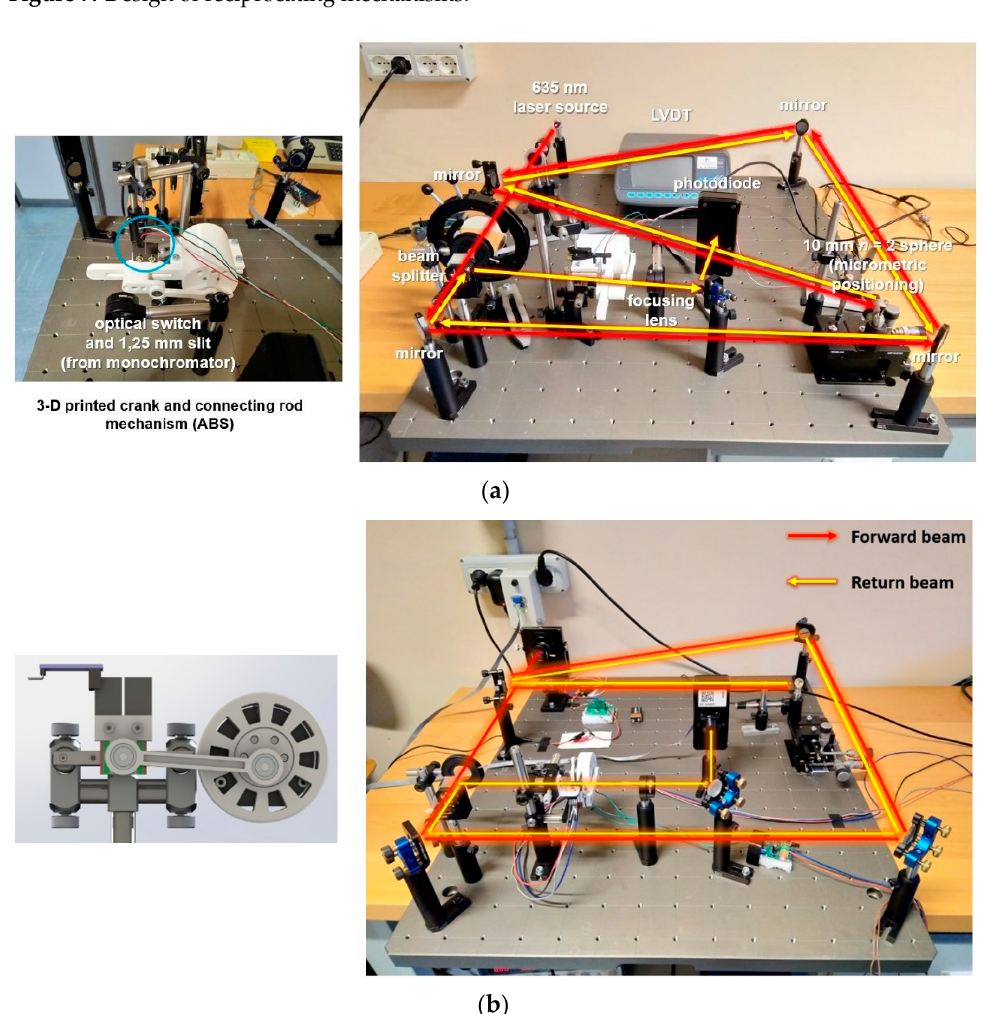
Figure 8. First ABS 3D-printed prototype of the slider-crank mechanisms and its test bed ( a ). Second prototype and its test bed ( b ).